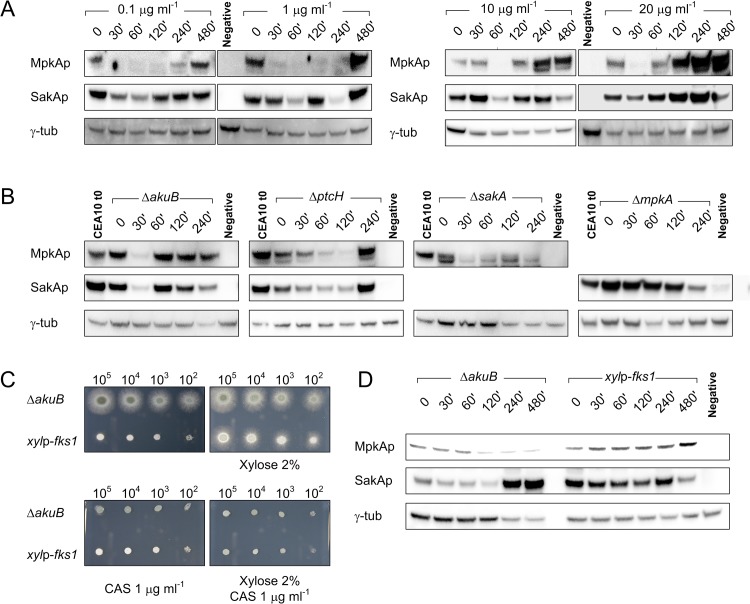
Western blot analysis to determine phosphorylation status of MpkA and SakA during caspofungin stress.(A) Western blot analysis to determine phosphorylation level of MpkA (using an Anti phospho-p42-44 antibody) and SakA (using an Anti phospho-p38 antibody) in A. fumigatus wild-type strain (using different caspofungin concentrations), and (B) in the ΔakuB, ΔmpkA, ΔsakA and ΔptcH mutant strains, exposed to 0.1 μg ml-1 of caspofungin. The γ-tubulin antibody was used as standard loading control in all experiments. Samples were collected at the reported time points (minutes after induction). (C) The recipient strain ΔakuB and the inducible xylp-fks1 mutant strain were tested against caspofungin (CAS) with and without 2% (w/v) xylose in the media. (D) The same strains were grown in liquid media with 2% (w/v) xylose and then transferred in fresh media with 1% (w/v) glucose as the sole carbon source. This experiment was performed to measure the effect of fks1 repression on MpkA and SakA phosphorylation.